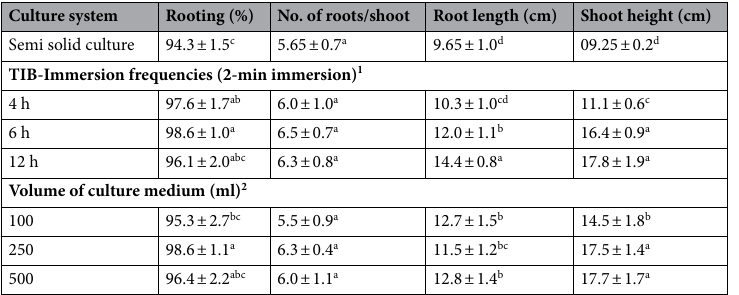
Table 2. Effect of the culture system, immersion frequency, and volume of culture medium on rooting, and shoot elongation. Results were recorded after 84 days of culture duration. Numbers represent the mean ± SD. Means with different letter are significantly different (DMRT, p ≤ 0.05). 1 Experiment carried out with 250 ml of culture medium and 150 numbers of inoculum used. 2 Experiment carried out with 2-min immersion for every 6 h and 150 numbers of inoculum